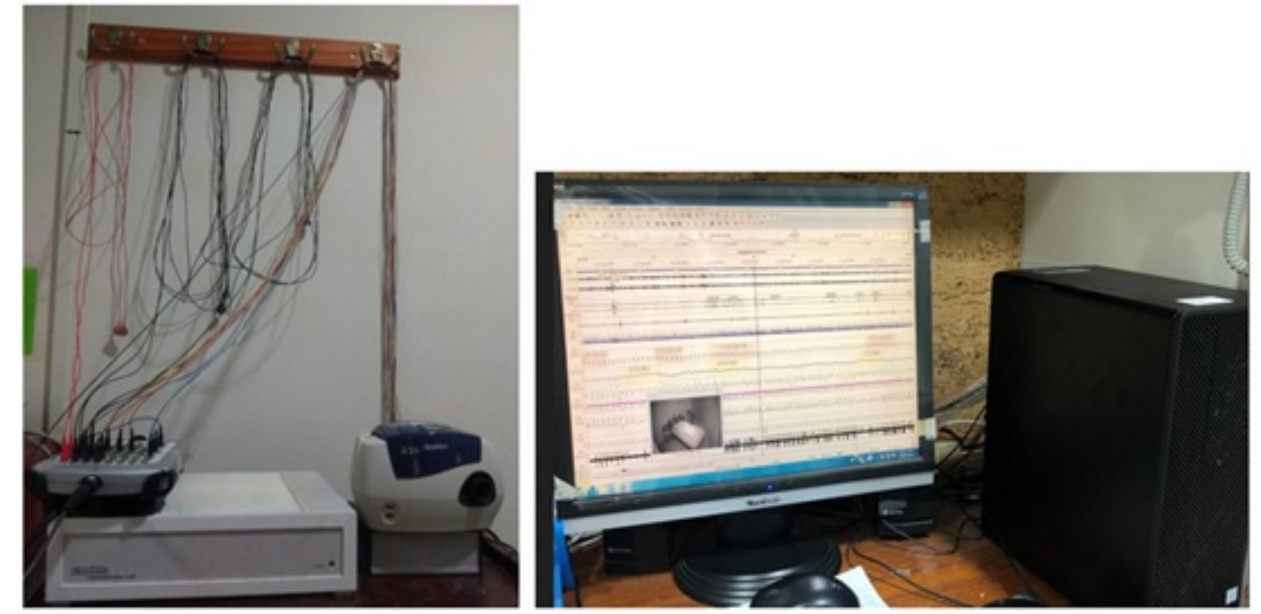
Figure 1. PSG recording device: the Embla N7000 System.